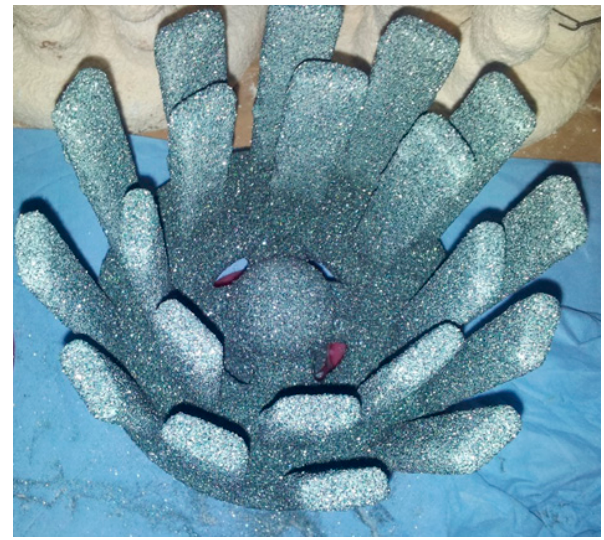
Figure 2. Example image of the SiC-based shell mold.